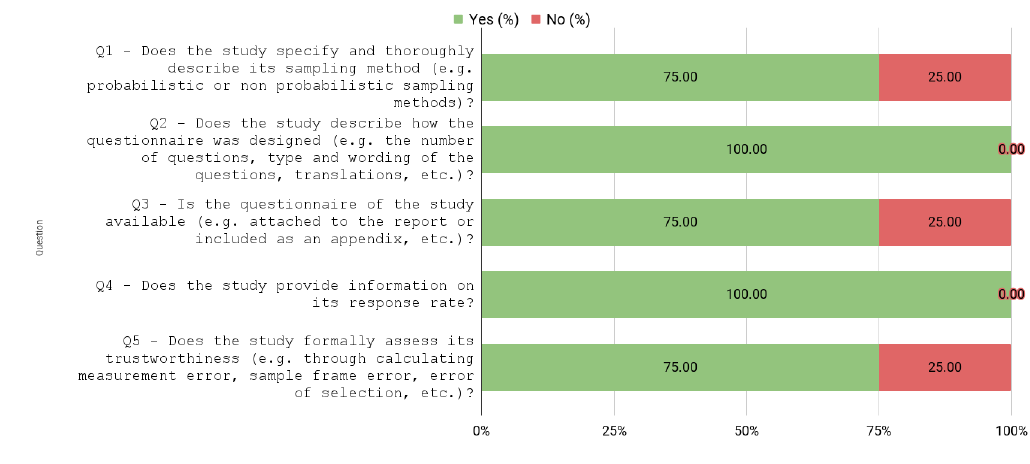
Figure 7. Answers to specific survey